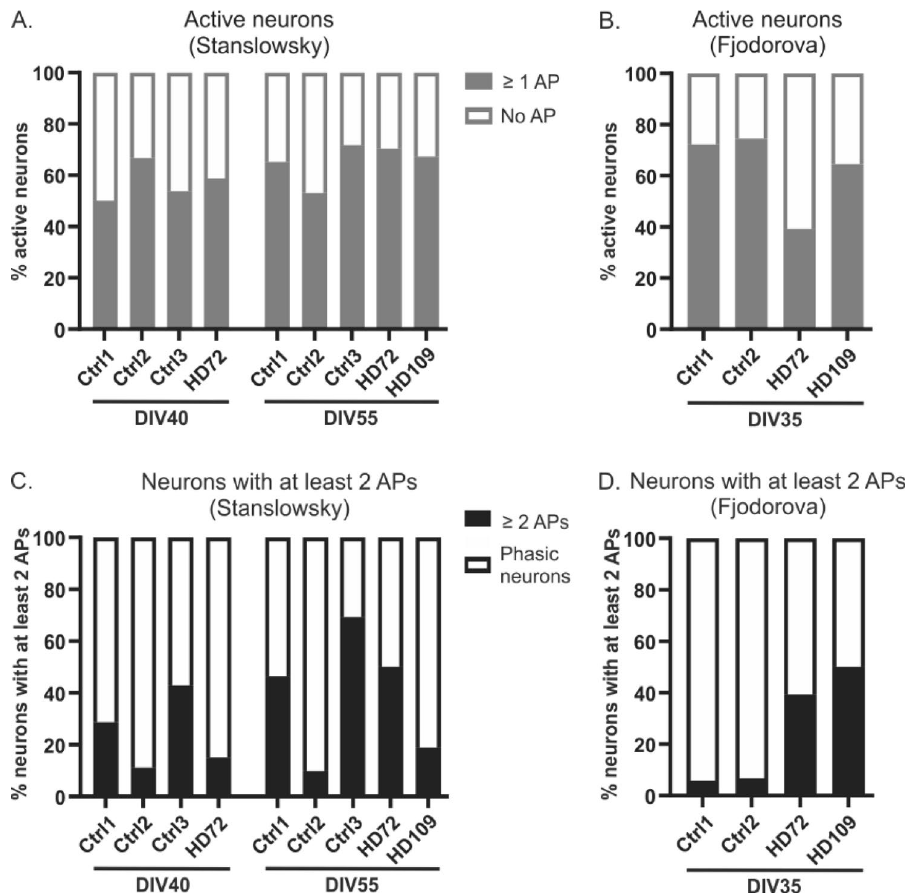
Figure 3. The percentage of active neurons and neurons firing more than 2 APs is increased following a longer time in culture for the Stanslowsky protocol. ( A ) The percentage of active control and HD neurons firing at least one AP at DIV40 ± 2 (n = 19 Ctrl1, 18 Ctrl2, 6 Ctrl3 and 20 HD72 neurons) and the same neurons with HD109 at DIV55 ± 3 (n = 60 Ctrl1, 51 Ctrl2, 28 Ctrl3, 38 HD72 and 37 HD109 neurons) for the Stanslowsky protocol. ( B ) The percentage of active control neurons firing at least 1 AP at DIV35 for the Fjodorova protocol (n = 34 Ctrl1, 73 Ctrl2, 49 HD72 and 20 HD109 neurons). ( C ) The percentage of phasic firing neurons (generating only 1 AP) and of tonic firing neurons (generating two and more APs) at DIV40 and DIV55 for the Stanslowsky protocol. ( D ) The percentage of phasic firing and of tonic firing neurons at DIV35 for the Fjodorova protocol. There was no extended time in culture for the hiPS cell-derived neurons of this protocol. See Supplementary Table S5 for